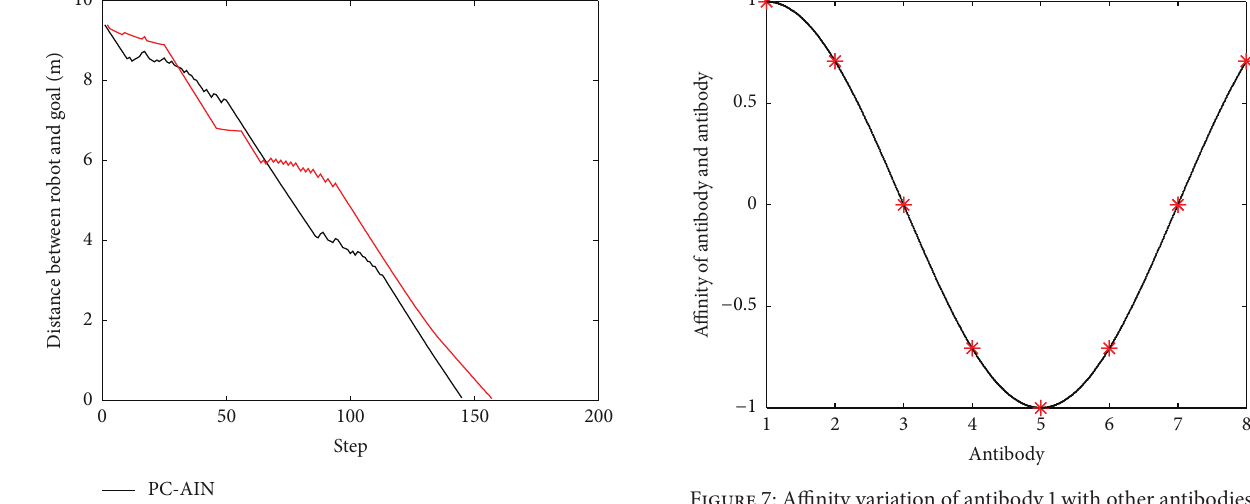
Figure 7: Affinity variation of antibody 1 with other antibodies.